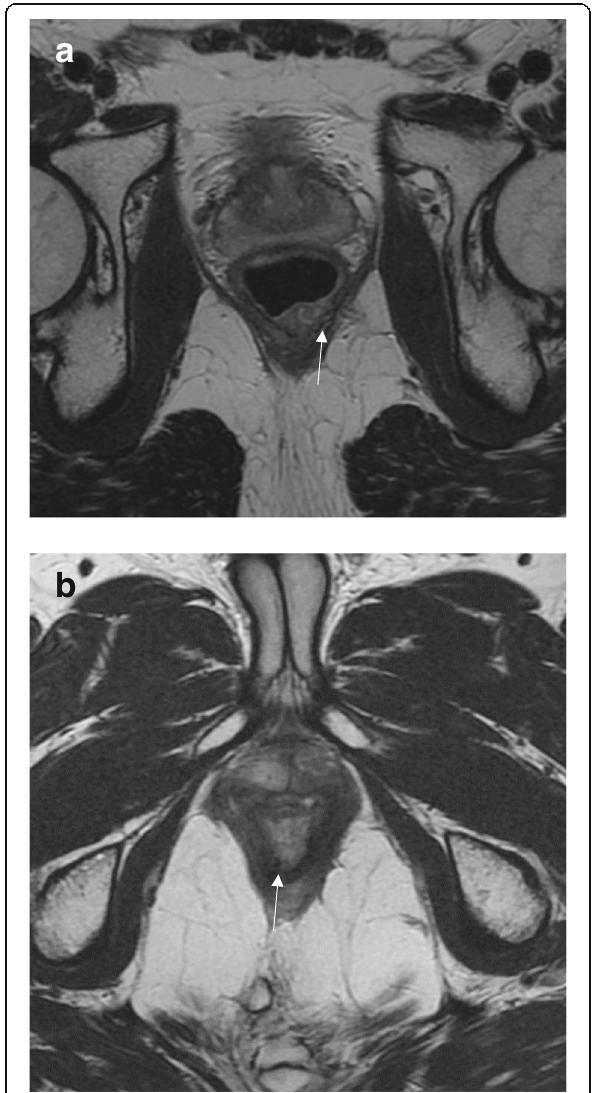
Fig. 17 Near-complete responses. a Restaging after 14 weeks of neoadjuvant CRT completion shows minimal residual high signal intensity lesion within the low rectal scar. Transanal endoscopic microsurgery (full-thickness local excision) was performed showing ypT1 lesion. b Follow-up exam after local excision shows the normal- appearing low signal intensity posterior scar